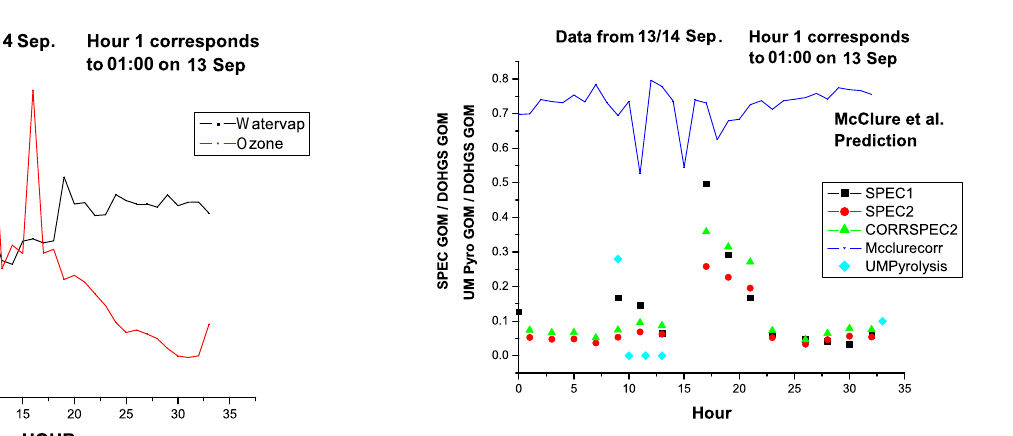
Figure 13. Expected denuder recovery based on the formula de- termined by McClure et al. which varies between a typical value of ∼ 70% dropping to ∼ 50% during the ozone spikes. The figure also shows the reported recoveries, i.e., the ratio of RGM as measured by either the UNR speciation systems or the 2P-LIF system divided by the value reported by the DOHGS